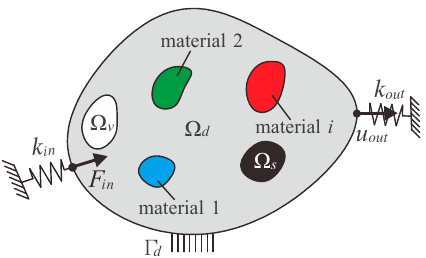
Figure 2. General formulation for multi-material topology optimization of compliant mechanisms.